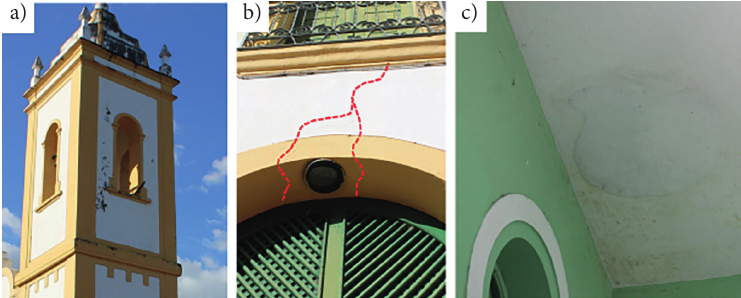
Fig. 6. Examples of the damages found during the inspection on Nossa Senhora das Dores Church: a) degradation by biological action; b) cracks in the arches and c) humidity presence in the slab